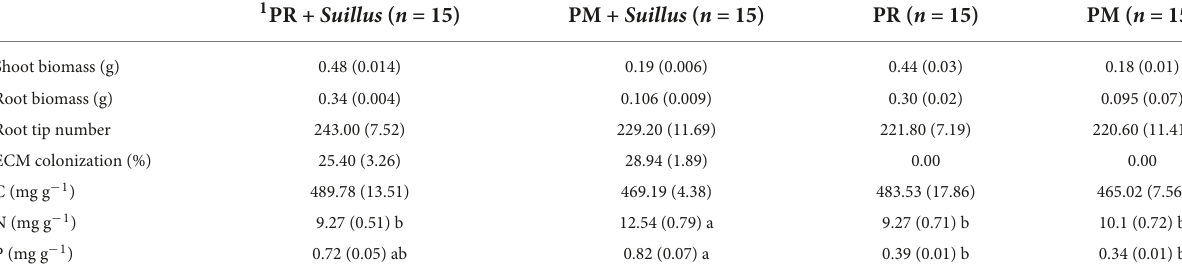
Data represents mean with the standard error in parentheses. 1 Values represent means ± standard errors. Different letters indicate significant ( P < 0.05) differences between individual meansassessedbytwo-wayfactorialanalysisofvariance(ANOVA)followedbyLeast-SignificantDifferencetesting.